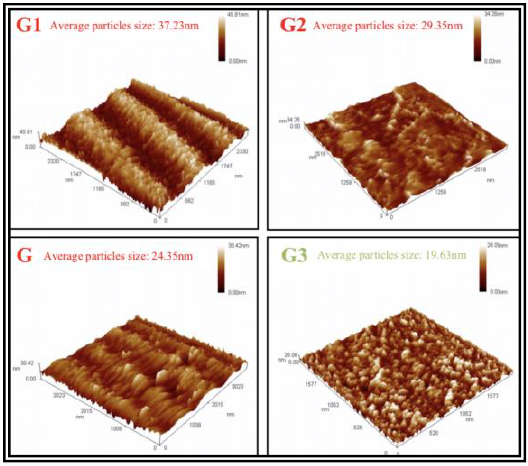
Figure 5: AFM 3D image of gold nanoparticles G, G1-3